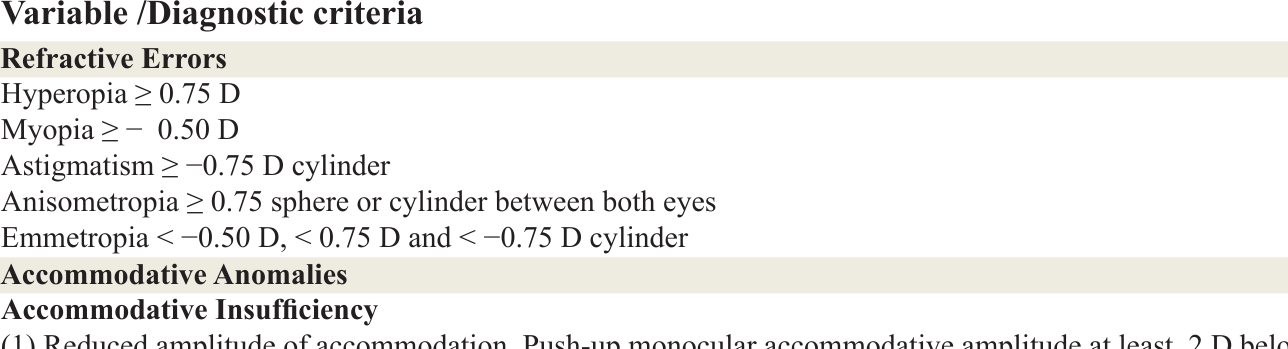
Table 1: Diagnostic criteria for refractive, accommodative and vergence anomalies Variable /Diagnostic